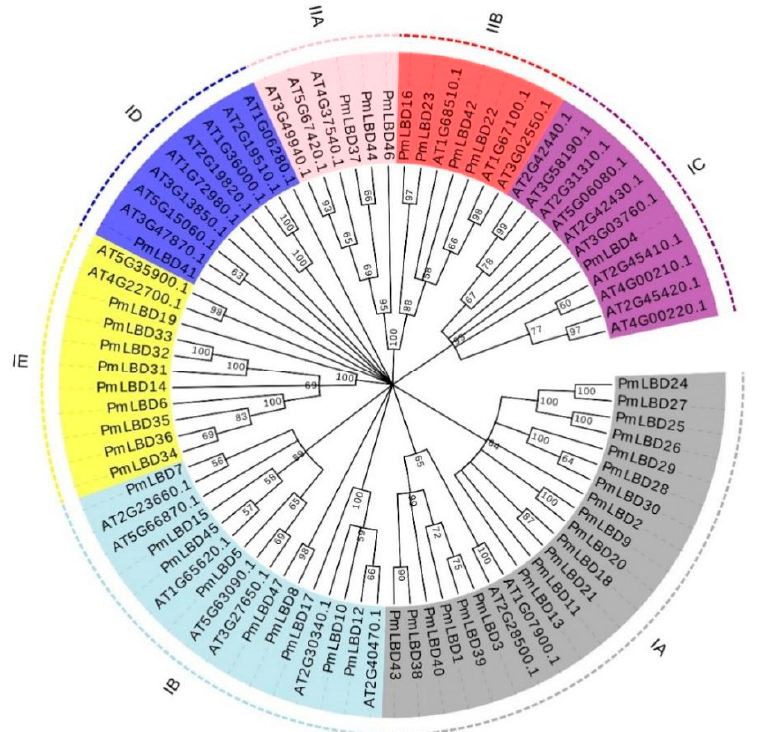
Figure 1. Phylogenetic grouping of members of the LBD family of P. massoniana . Gene names of different colors correspond to the groups of the same color in the outermost circle, and the numbers on the nodes in the figure indicate branch support values.